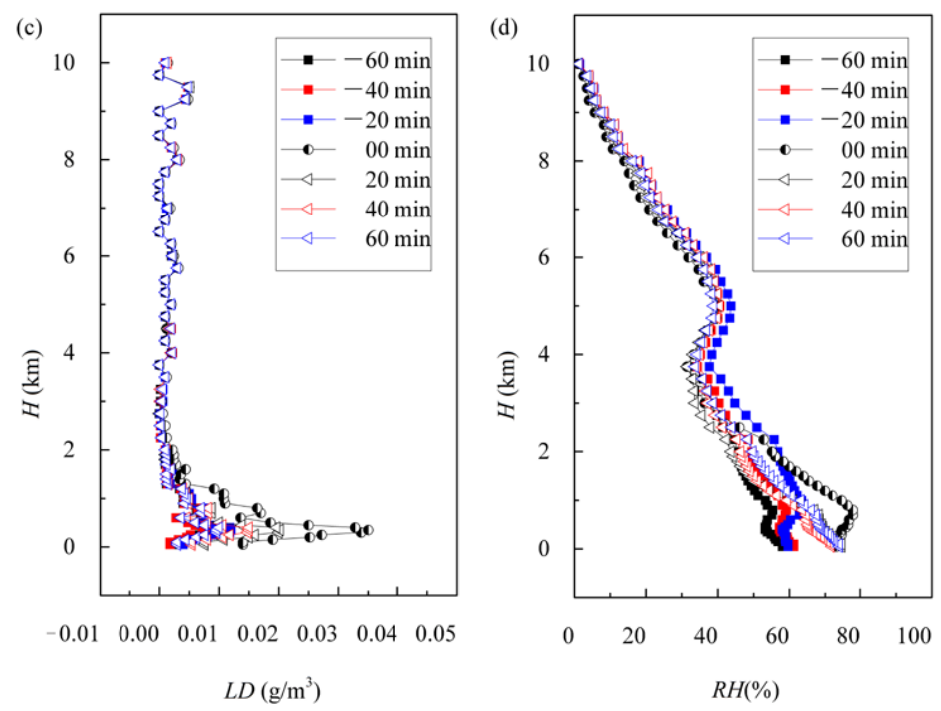
Figure 11. Comparison of temperature ( a ), vapour density ( b ), liquid water content ( c ), and relative humidity ( d ) profiles before and during the snow process. The time instant t t (h) = 0 h represents one hour before the precipitation process.